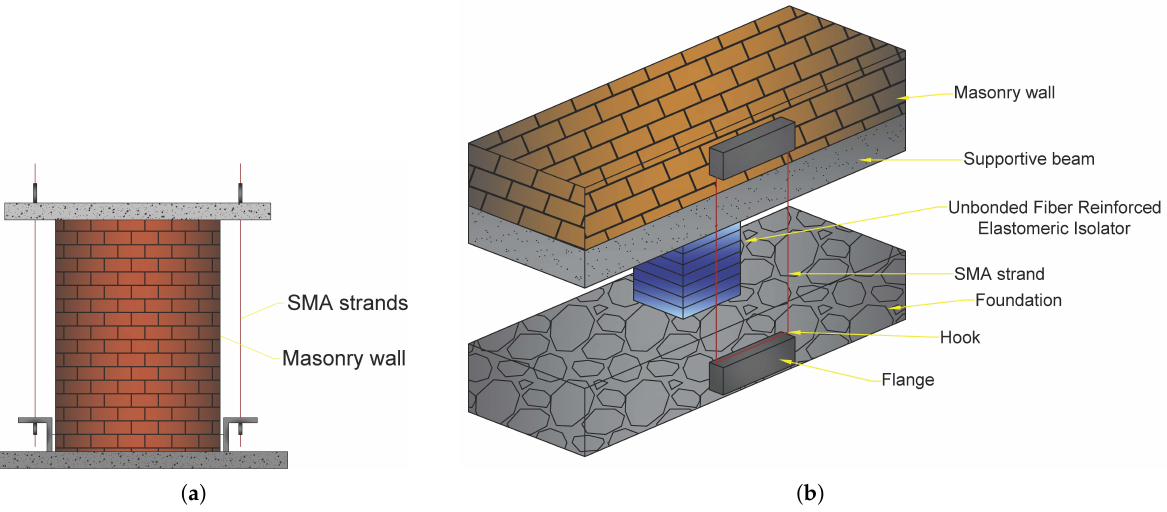
Figure 18. ( a ) The schematic of the proposed system with SMA strands for connection bonds [79]; ( b ) the schematic of the proposed system and SMA strand in the isolation system of masonry constructions [80] (figures are taken from